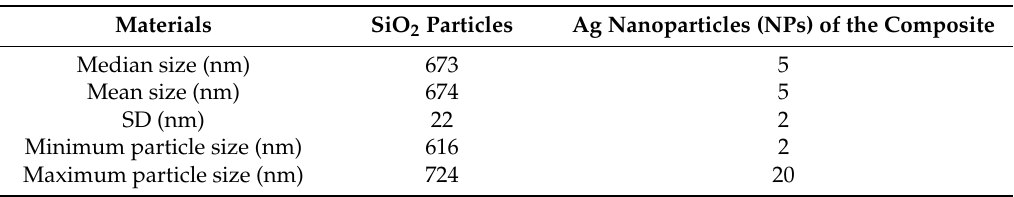
Figure 1. SEM images showing ( A ) the spherical pristine SiO 2 particles; and ( B ) the raspberry-like Ag–SiO 2 composite with surface-immobilized Ag NPs. Table 1. The sizes of SiO 2 particles and Ag NPs on the composite. The number of measured particles is 50 at a minimum for each sample. standard deviation (SD).